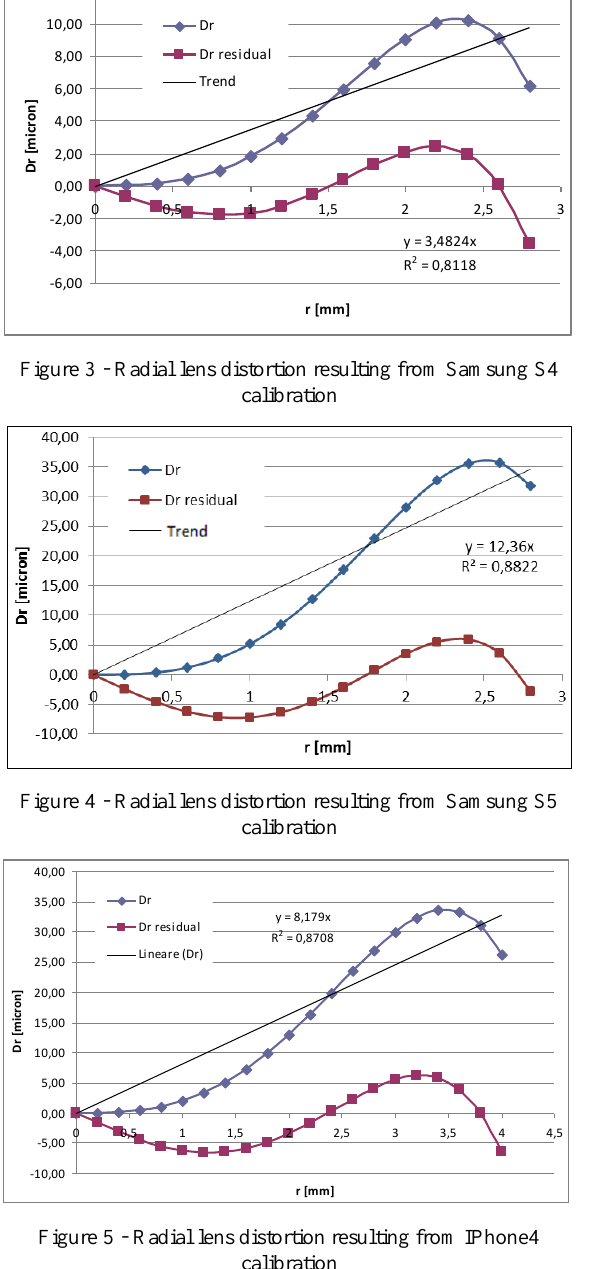
Figure 5 - Radial lens distortion resulting from IPhone4 calibration